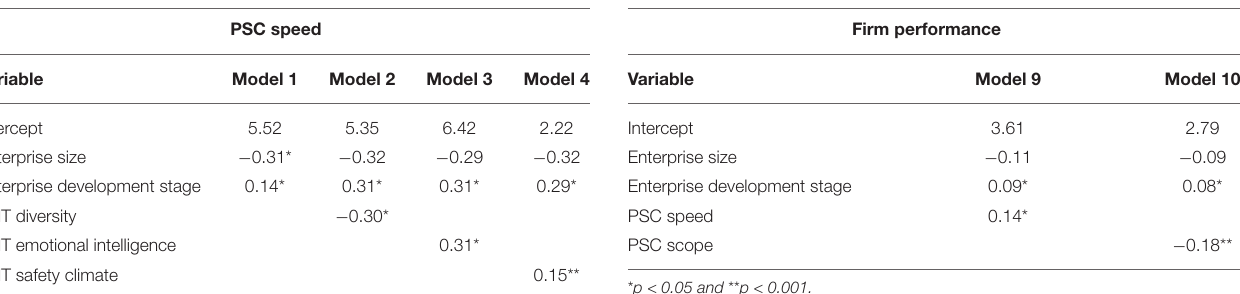
TABLE 3 | Regression analysis: Effects on PSC speed.